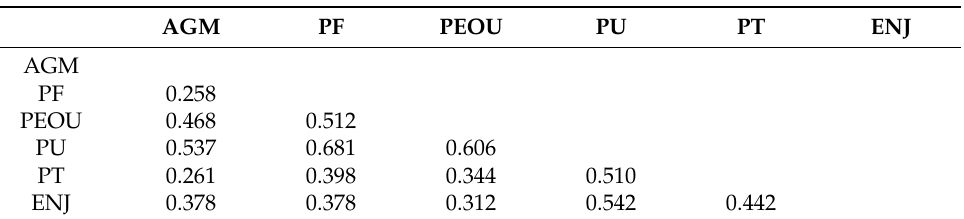
Table 7. Heterotrait-Monotrait ratio (HTMT).